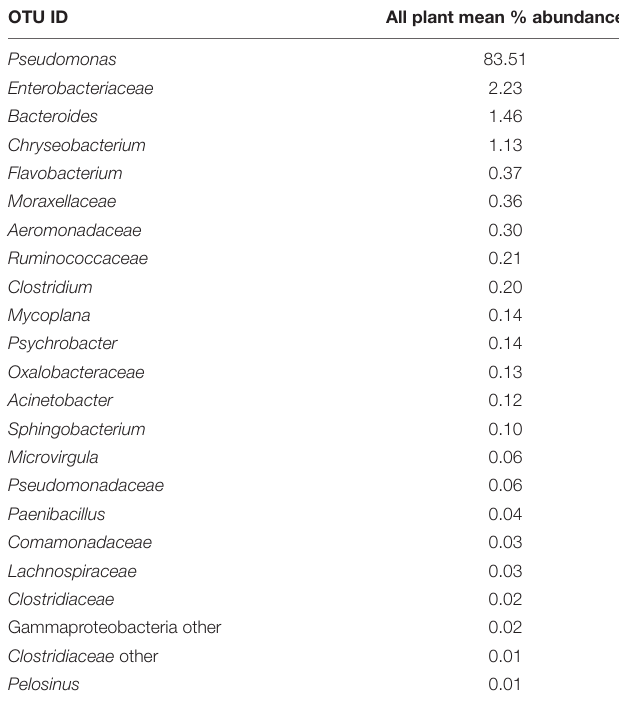
TABLE 3 | All identified microorganisms present at post-chill and processing